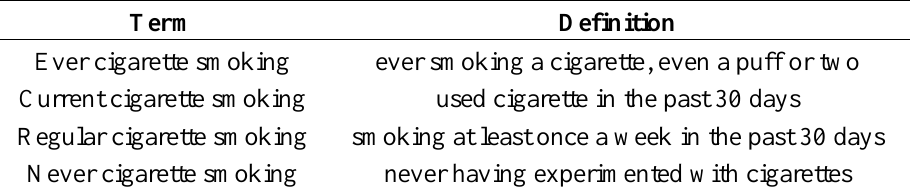
Table 1. Definitions of terms